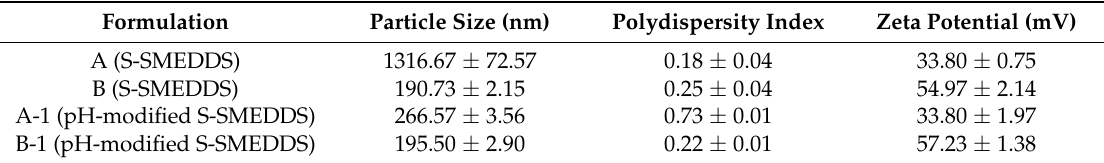
Figure 3. TEM of raloxifene hydrochloride (RLH)-loaded supersaturatable self-microemulsifying drug delivery system (S-SMEDDS) ( a ) Formulation A-1 and ( b ) Formulation B-1. Table 4. Particle size, zeta potential, and polydispersity index of S-SMEDDSs and pH-modified S-SMEDDSs in distilled water. All data are means ± SDs ( n = 3).